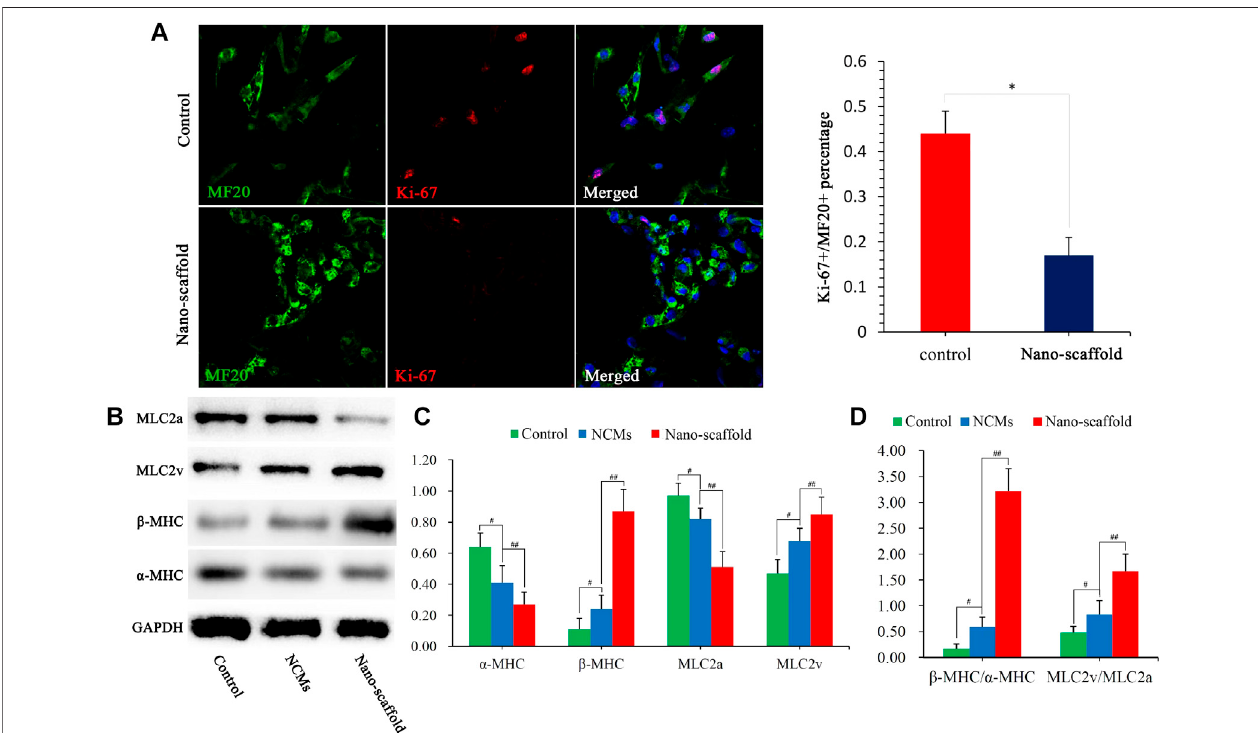
FIGURE 4 | Cardiac mature proteins were analyzed by different assays. (A) Co-staining of Ki-67 and MF20 to detect the proliferation ability of iPSC-CMs, and Ki- 67 + /MF20 + percentage was quanti fi ed. (B) Proteinexpression of α -MHC, β -MHC, MLC2a, and MLC2v wereassessed in control, NCMsand nano-scaffold groups. The values are normalized to the housekeeping gene GAPDH. (C) Quanti fi cation of α -MHC, β -MHC, MLC2a and MLC2v protein levels in NCMs, control and nano-scaffold groups. (D) Expression ratio of β -MHC/ α -MHC and MLC2v/MLC2a as mature markers in three groups. Expression levers of each gene were normalized to GAPDH. Data are presented as mean ± SEM, # p < 0.05 vs. control; ## p < 0.05 vs. NCMs.